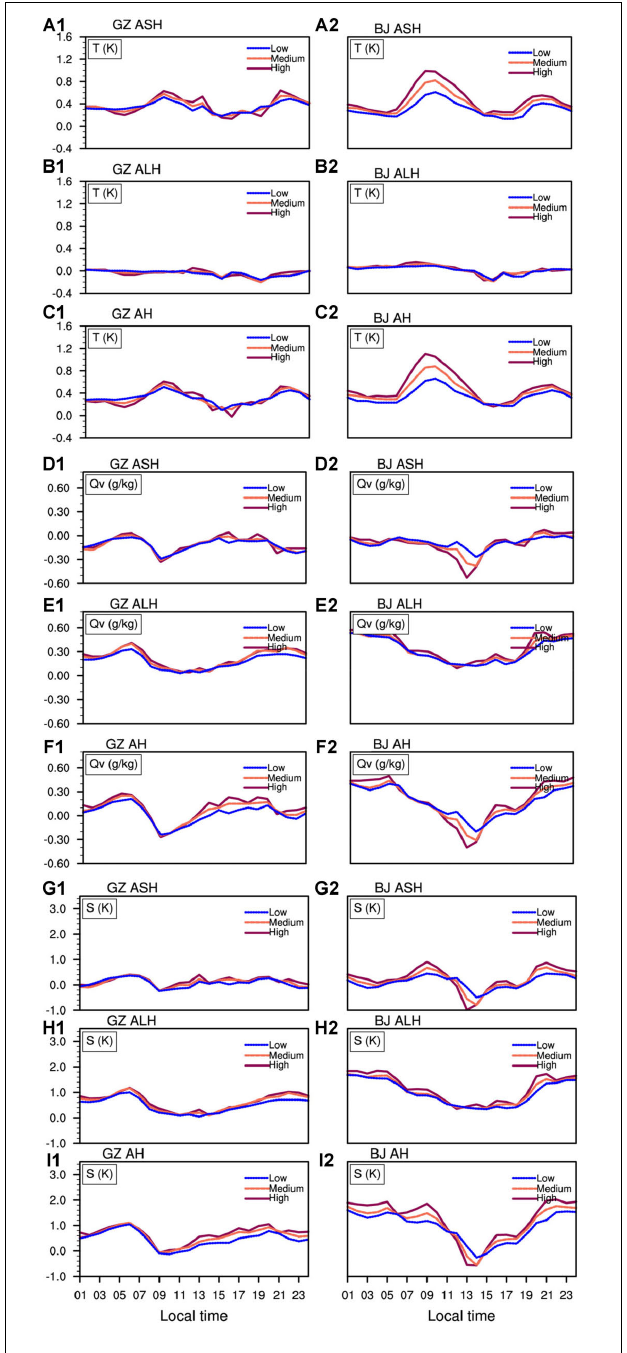
FIGURE 6 | (A-I) The diurnal variations of temperature (K), humidity (g/kg), moist entropy (K) in high-/medium-/low-density urban areas (dark red/light red/blue) due to ASH, ALH, AH release. The curves denote the difference fields between Real run and other experiments (refer to Group 1 experiment in Table 4 ). Left and right panels are GZ and BJ, respectively.